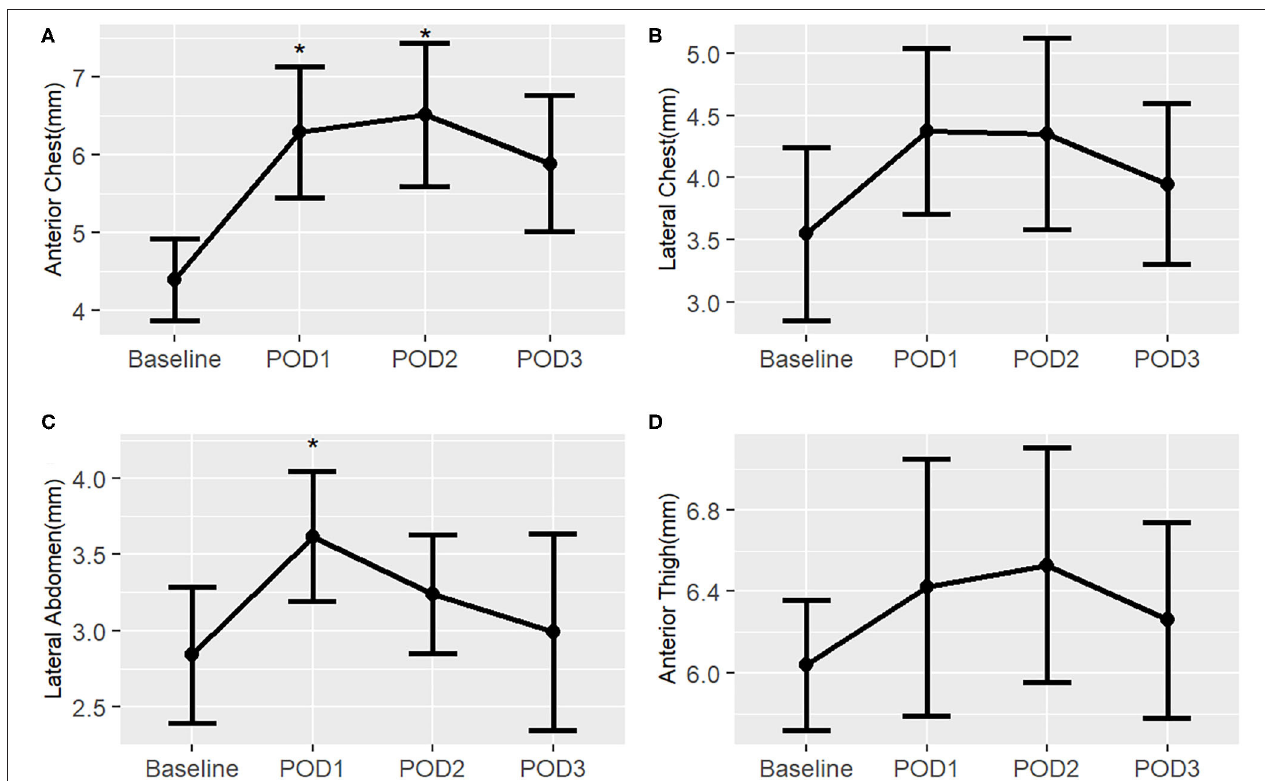
FIGURE 8 | Post-operative changes in mean subcutaneous tissue thickness from baseline of surgical infants, by right-sided body site. *, p < 0.05. (A) Anterior chest; (B) Lateral chest; (C) Lateral abdomen; (D) Anterior thigh.